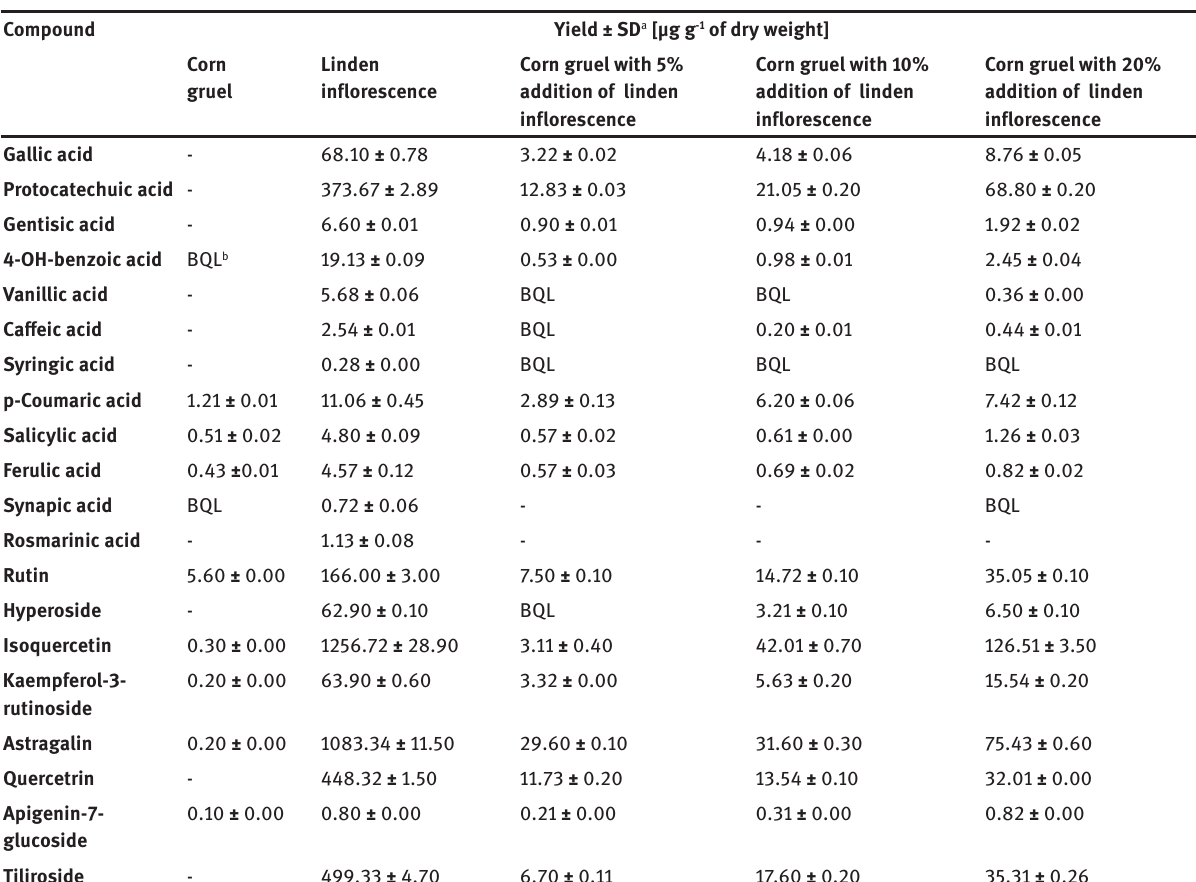
Table 4 : Polyphenols content (n = 3).